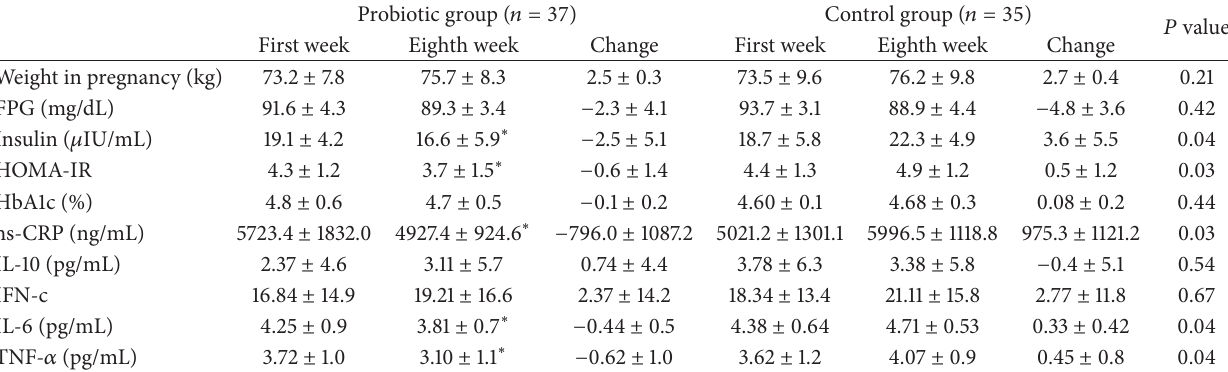
Table 3: Characteristics of patients who received probiotic or placebo, at baseline and after 8 weeks from diagnostic oral glucose tolerance test (OGTT).